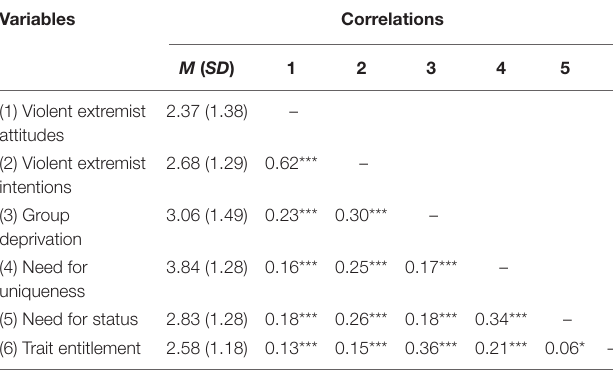
TABLE 1 | Descriptive statistics and correlations among variables of interest, Study 1A.